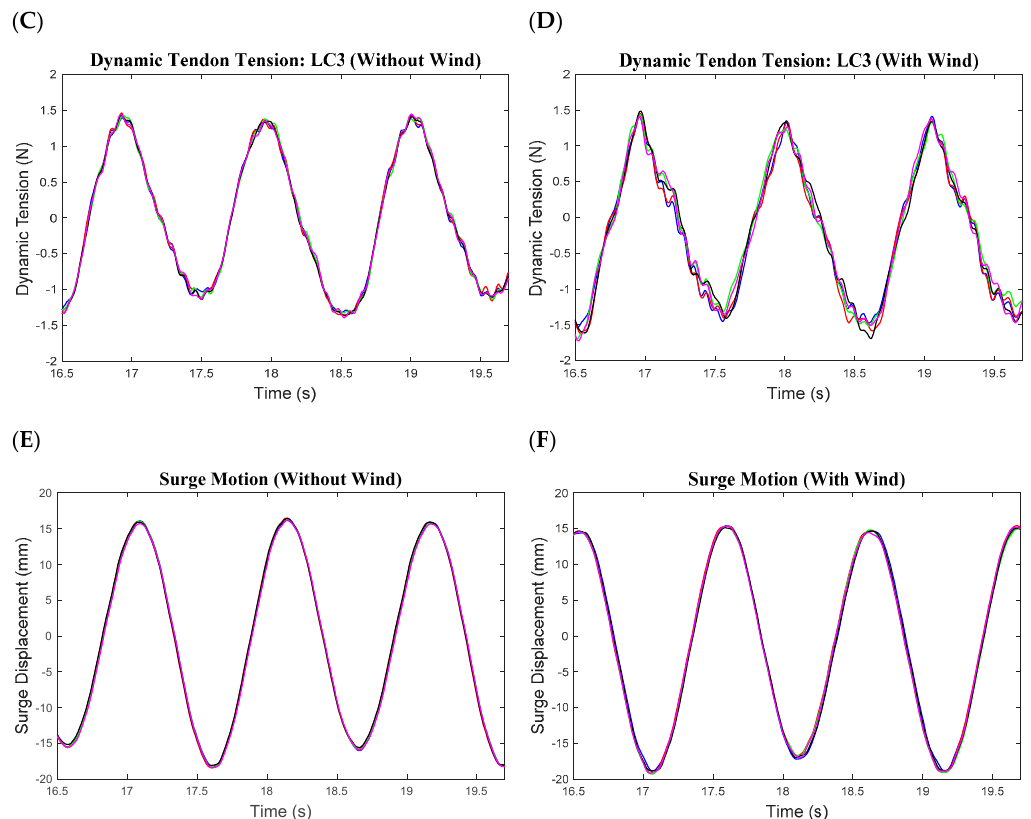
Figure 10. Time history of wave elevations, dynamic tensions and surge motions for five repeated runs. Table 8. Results of repeatability analysis for wave only runs.